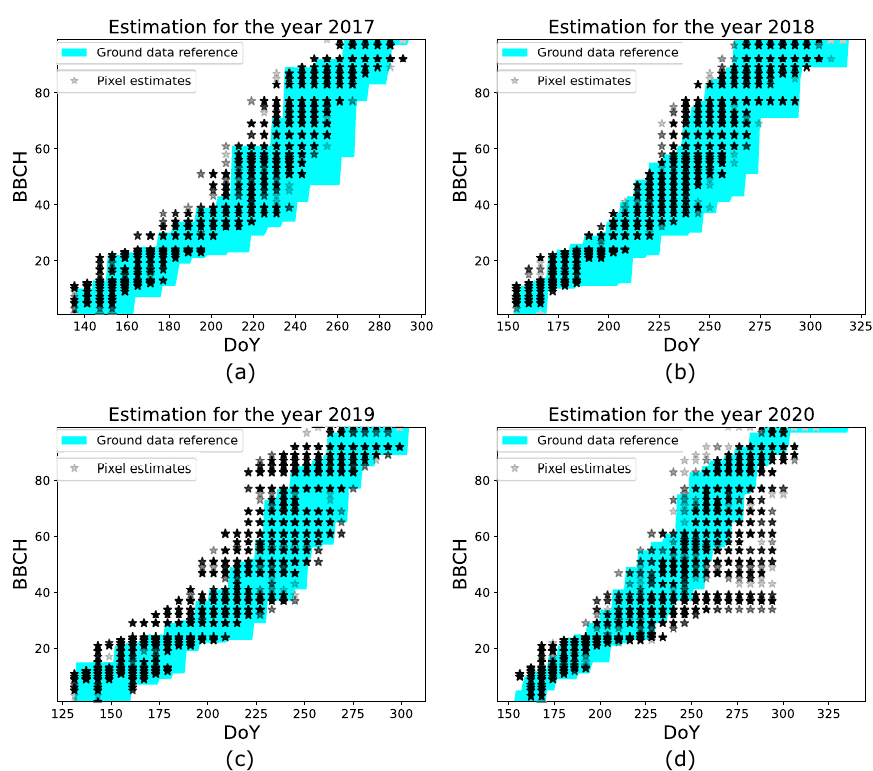
Figure 6. Analysis on the pixel level estimation for all the experiments, ( a – d ) estimation performance for the years